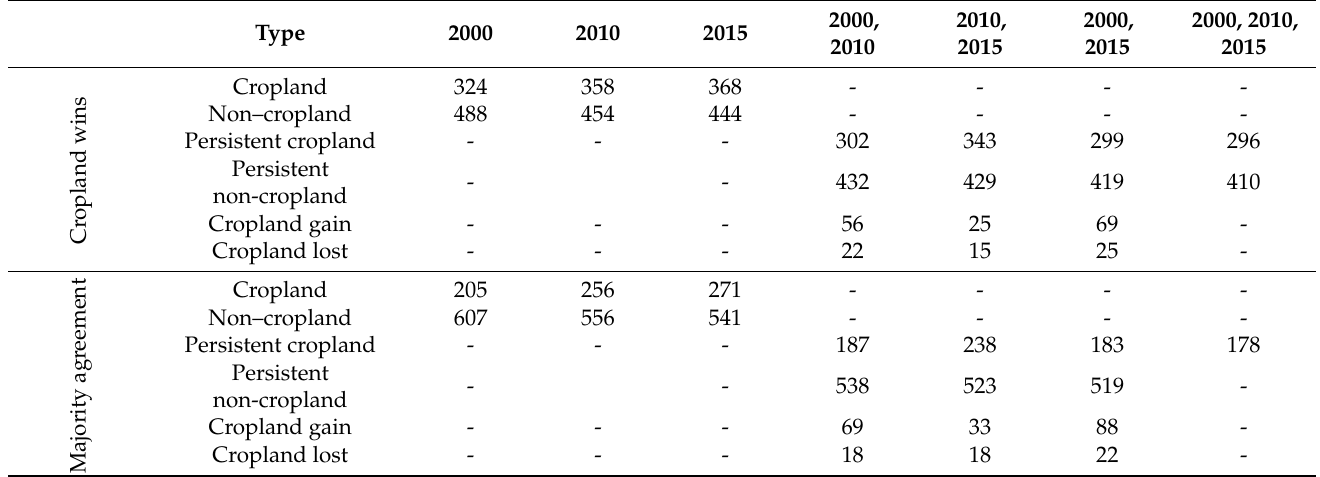
Table 2. Validation points and label distributions grouped according to year of observation, and by intervals defining different change